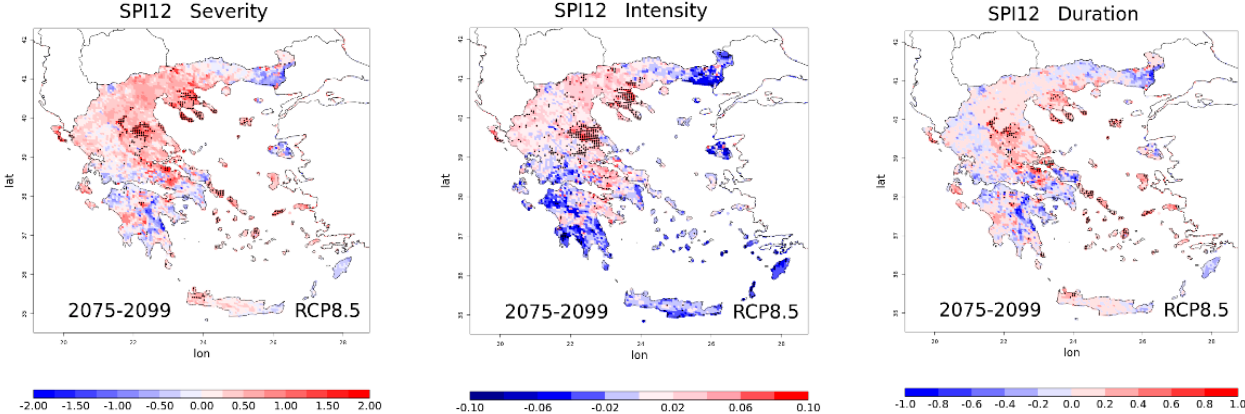
Figure 14. Trends of severity ( left ), intensity ( center ), and duration ( right ) for the 12 − months SPI under RCP4.5 and RCP8.5 for the period 2025–2049 and 2075–2099 over the area of Greece. The black dotted areas show significant changes in the drought characteristics at the 5% significance level.